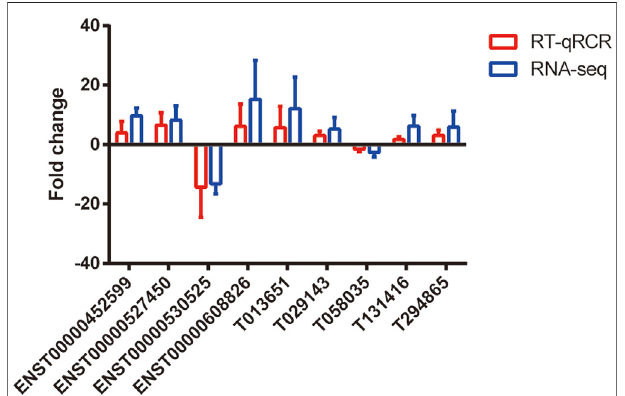
FIGURE 4 | Validation of differential expression of lncRNAs. RT-qPCR was used to verify the expression levels of these selected lncRNAs ( p < 0.05). The blue points represent RT-qPCR, while the red points represent the gene chip of RNA-seq. n =